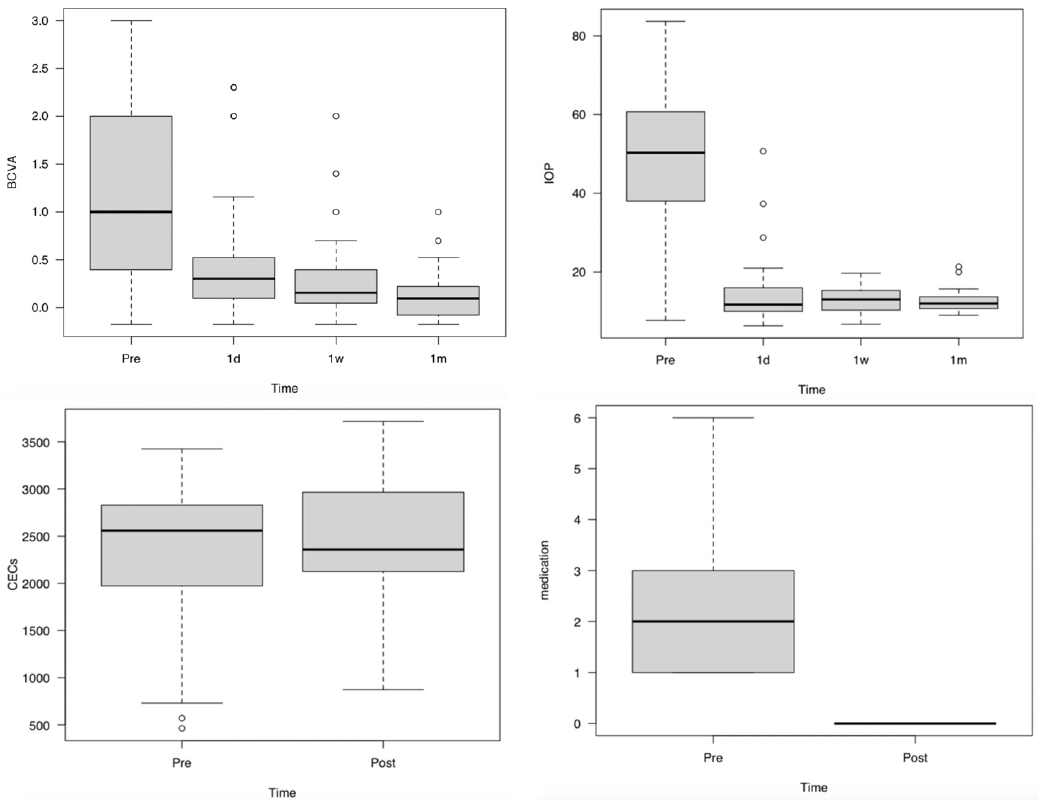
Figure 1. Change in BCVA, IOP, and the number of corneal endothelial cells. BCVA improved significantly for all 41 eyes at 1d, 1w, and 1m compared with that at Pre ( p = 0.0002, p < 0.0001, and p < 0.0001, respectively) and significantly at 1m compared with that at 1d ( p = 0.0061). IOP decreased significantly at 1d, 1w, and 1m compared with that at Pre ( p < 0.0001, <0.0001, and <0.0001, respectively). CECs did differ not significantly between Pre and 1m ( p = 0.784), and the number of IOP-lowering medications decreased significantly from Pre to 1m ( p < 0.0001). Abbreviations: BCVA, LogMAR-converted best corrected visual acuity; IOP, intraocular pressure (mmHg); CECs, number of corneal epithelial cells (/mm 2 ); medication, number of glaucoma medication; Pre, Preoperative period; 1d, The day after surgery; 1w, 1 week after surgery; and 1m Post, 1 month after surgery.